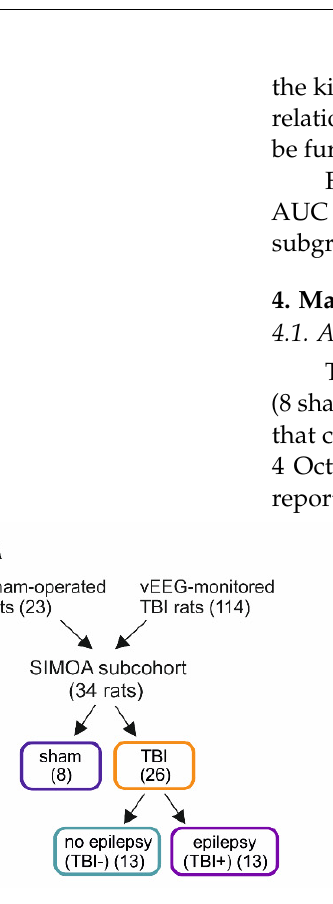
Figure 7. Study design. ( A ) The first 34 rats [8 sham-operated experimental controls, and 26 with traumatic brain injury (TBI)] completing the 6-month follow-up in the EPITARGET animal cohort of 137 animals (23 sham, and 114 TBI) were included in the present analysis [22,37]. Within the TBI group, 13 rats exhibited no unprovoked seizures in video-encephalogram (vEEG) (TBI − ). In 13 rats, we found at least 1 unprovoked seizure during the 6th month vEEG (TBI+). The number of animals was based on a power calculation. That is, we expected the plasma NF-L to separate the TBI − and TBI+ groups with AUC 0.800 (MedCalc software). ( B ) Timing of the tests included in the present analysis (for a complete study design, see [22]). During the 6-month follow-up, rats underwent blood sampling via the tail vein, behavioral tests (neuroscore and Morris water maze), in vivo quantitative T 2 magnetic resonance imaging (MRI), and 1-month continuous vEEG monitoring. Plasma levels of neurofilament light chain were assessed using a single molecule array (SIMOA). Abbreviations: D,